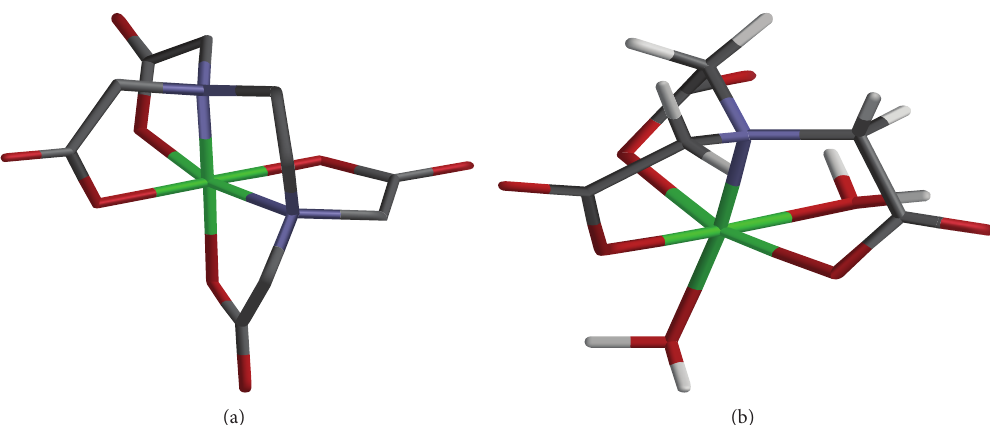
Figure 4: Optimized structures of the complexes [Cr(EDTA)] (a) and [Cr(NTA)(H 2 O) 2 ] (b). The green color represents the chrome atom; red: oxygen, blue: nitrogen, and gray: carbon.